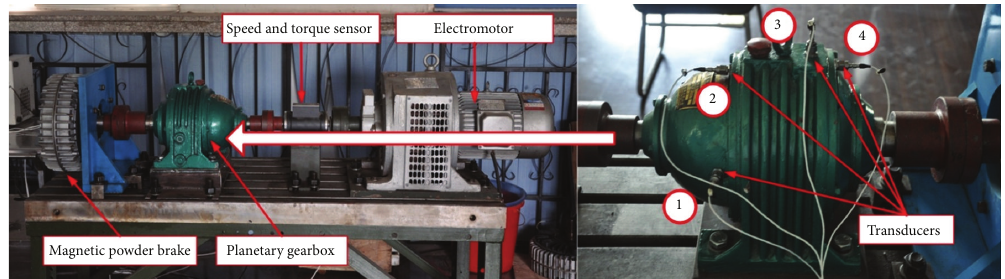
Figure 22: Planetary gearbox fault test rig.